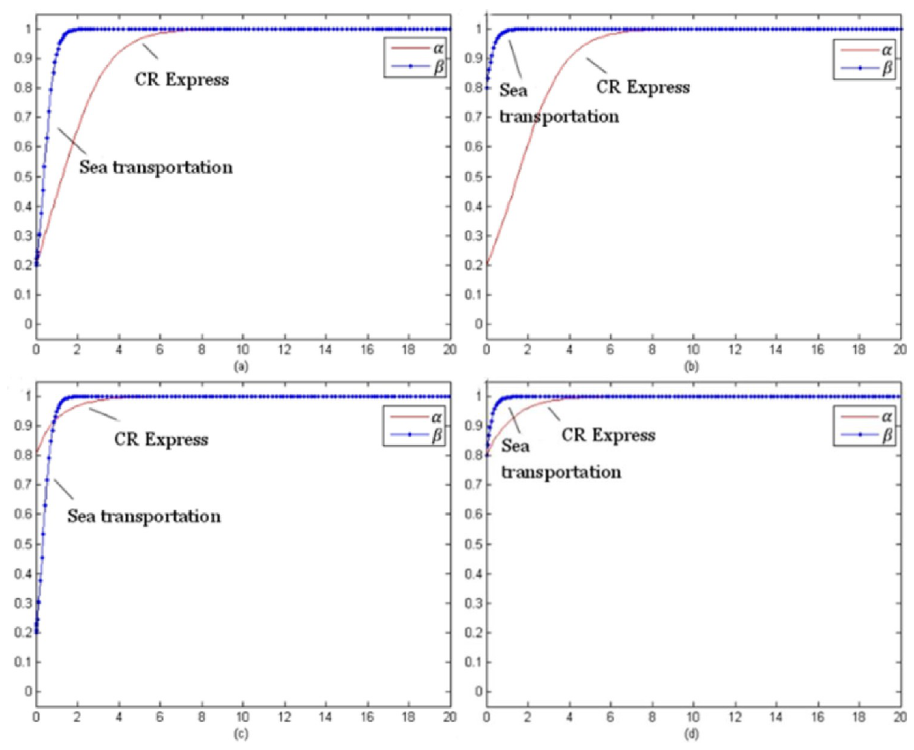
Fig 6. Evolution trend of competition game of industrial accessories transportation (with subsidies).